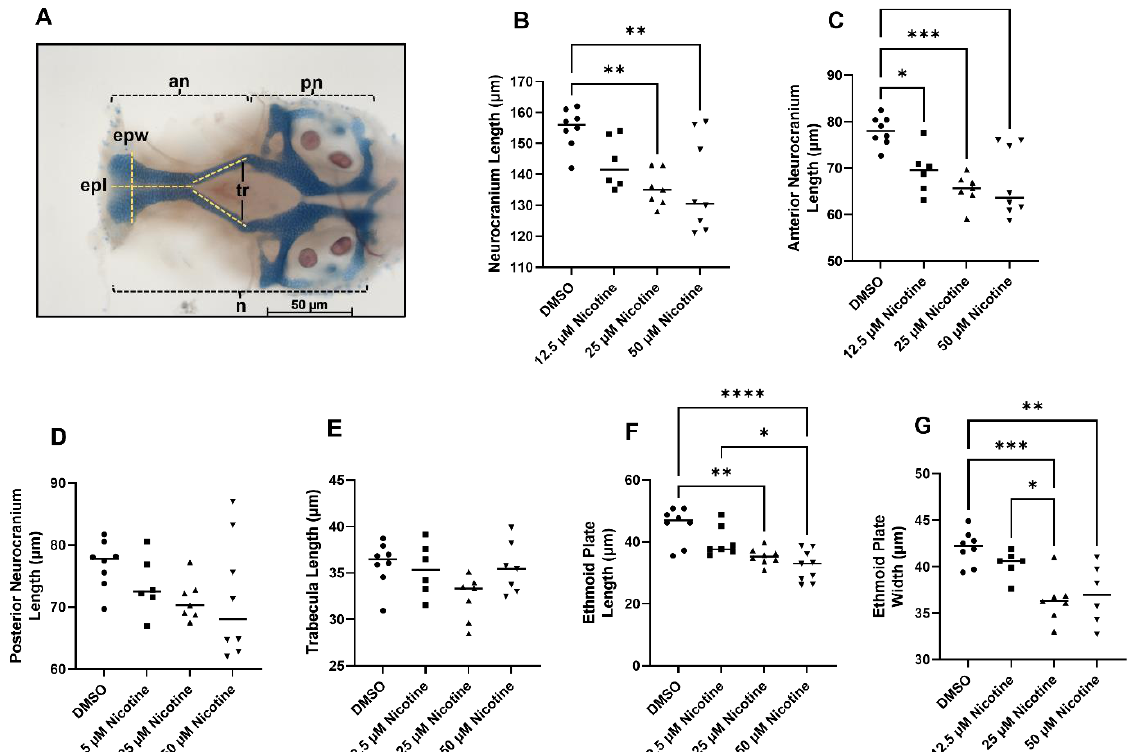
Figure 4. Embryonic nicotine exposure reduces cartilage in the neurocranium. ( A ) Neurocranium cartilages measurements. ( B ) Neurocranium total length was reduced following exposure to 25 or 50 µM nicotine. ( C ) The anterior neurocranium was reduced in all nicotine-exposed groups. ( D ) Length of the posterior neurocranium and ( E ) the trabeculae were not affected. Ethmoid plate in length ( F ) and width ( G ) was reduced by exposure to 25 µM or 50 µM nicotine. Sample sizes are as follows: DMSO n = 8; 12.5 µM nicotine n = 6; 25 µM nicotine n = 7; and 50 µM nicotine n = 8; epl, plate length; epw, plate width; tr, trabecula; n, neurocranium; an, anterior neurocranium; pn, pos- terior neurocranium. * = p < 0.05; ** = p <0.01; *** = p < 0.001; **** = p < 0.0001. All images were captured at 10× magnification. Scale bar 50 µm.